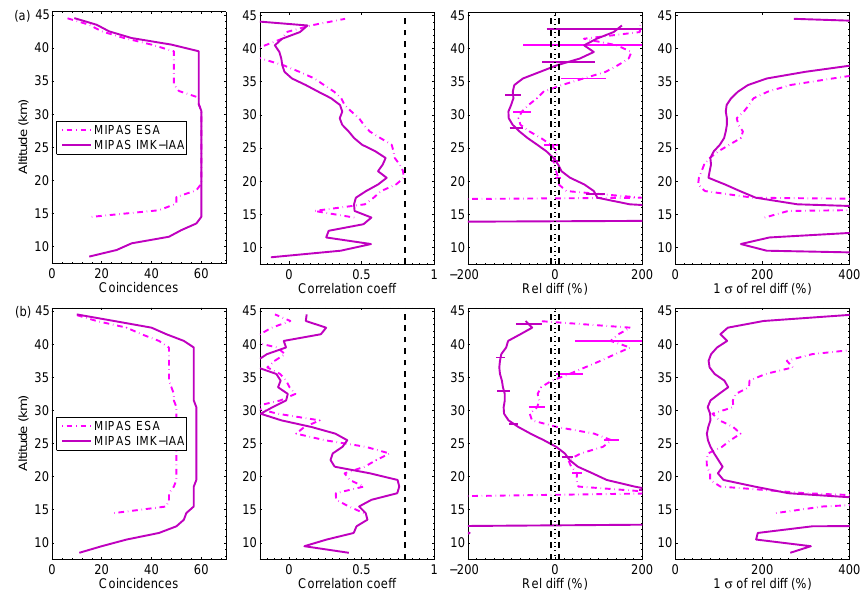
Figure 12. Evening N 2 O 5 comparisons between ACE-FTS and MIPAS measurements: (a) with diurnal scaling and coincidence criteria of within 3h and 100km and (b) without diurnal scaling and with coincidence criteria of within 20min and 200km. Error bars in the relative difference profiles represent the standard error of the mean.